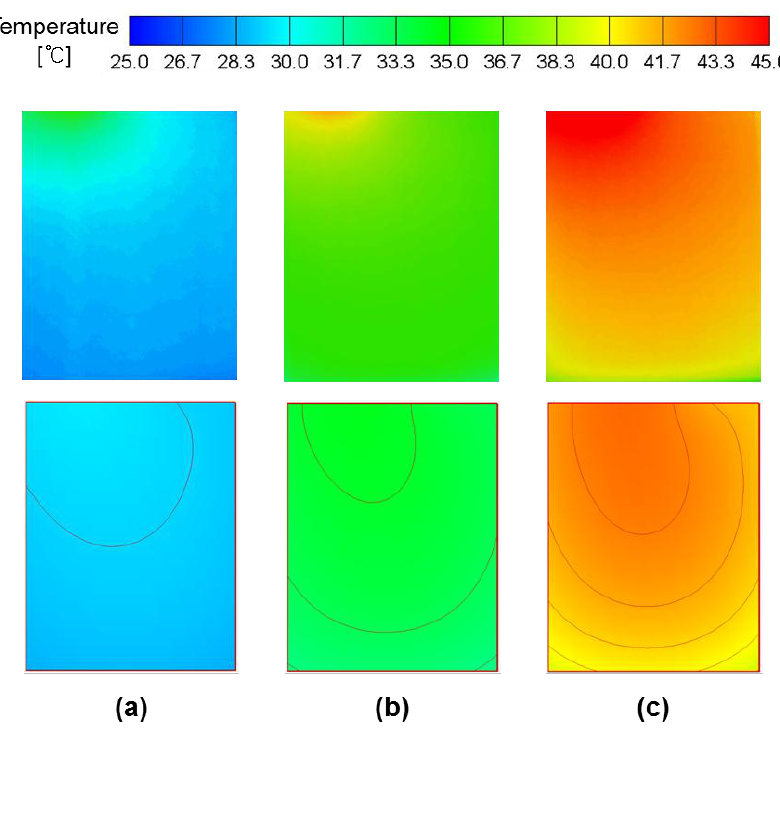
Figure 2. Temperature distributions based on the experimental IR (Infrared) image ( upper ) and the modeling ( lower ) for the LIB cell at the discharge times of ( a ) 450 s, ( b ) 900 s, and ( c ) 1800 s with 2 C